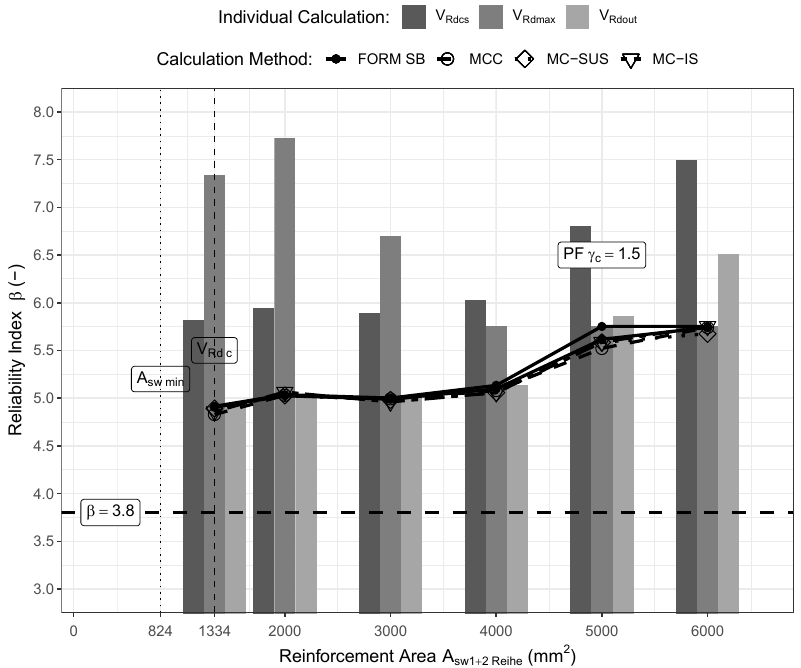
Figure 4. Systems reliability analysis for a partial factor 𝛾 (cid:3004) of 1.5.